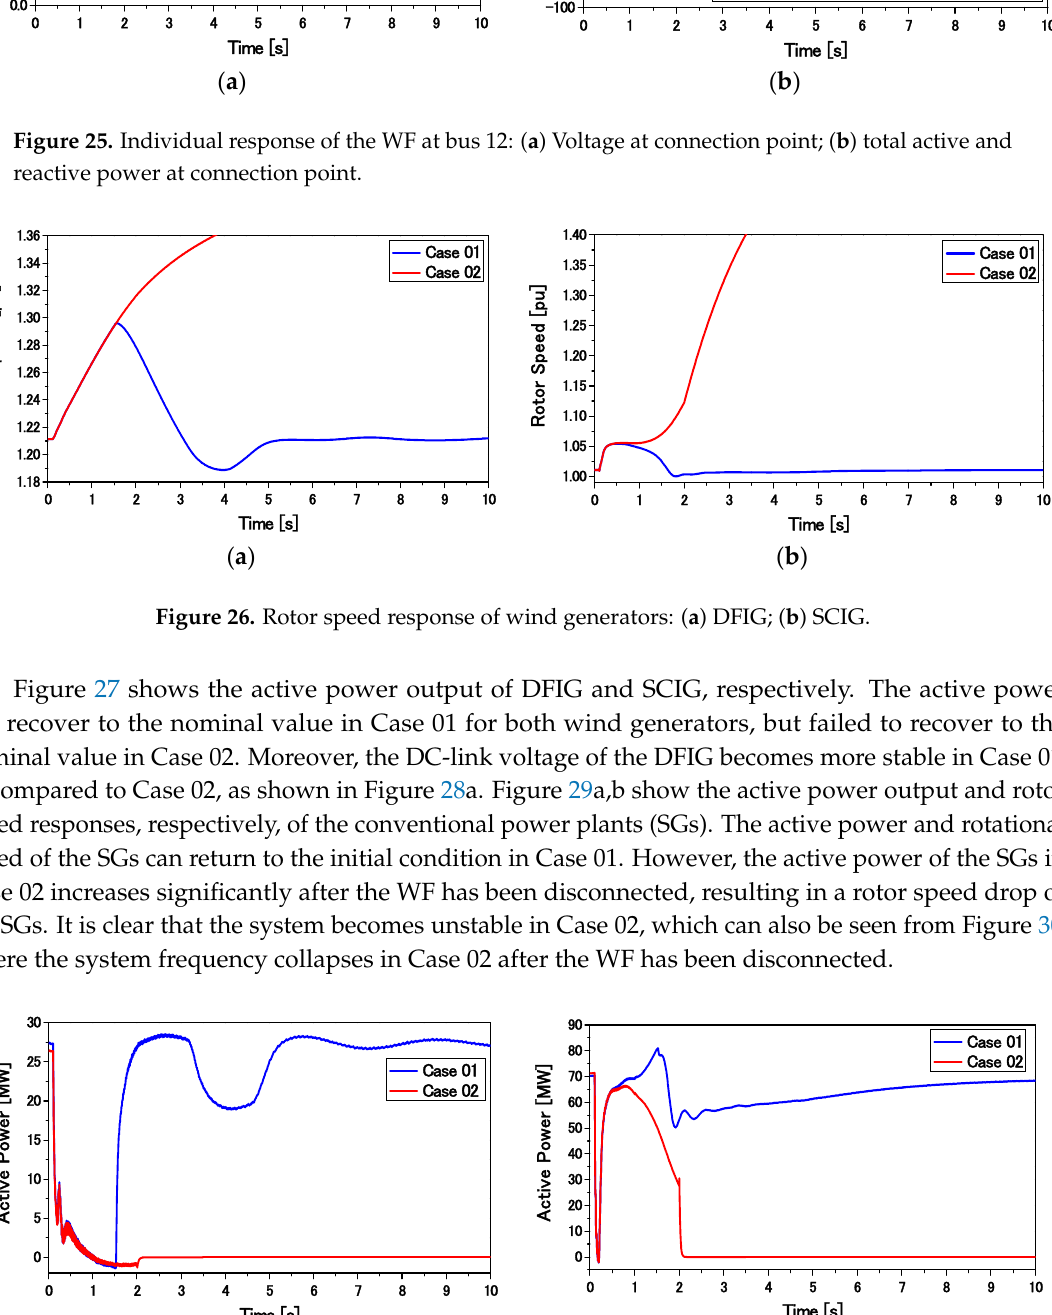
Figure 25. Individual response of the WF at bus 12: ( a ) Voltage at connection point; ( b ) total active and reactive power at connection point.